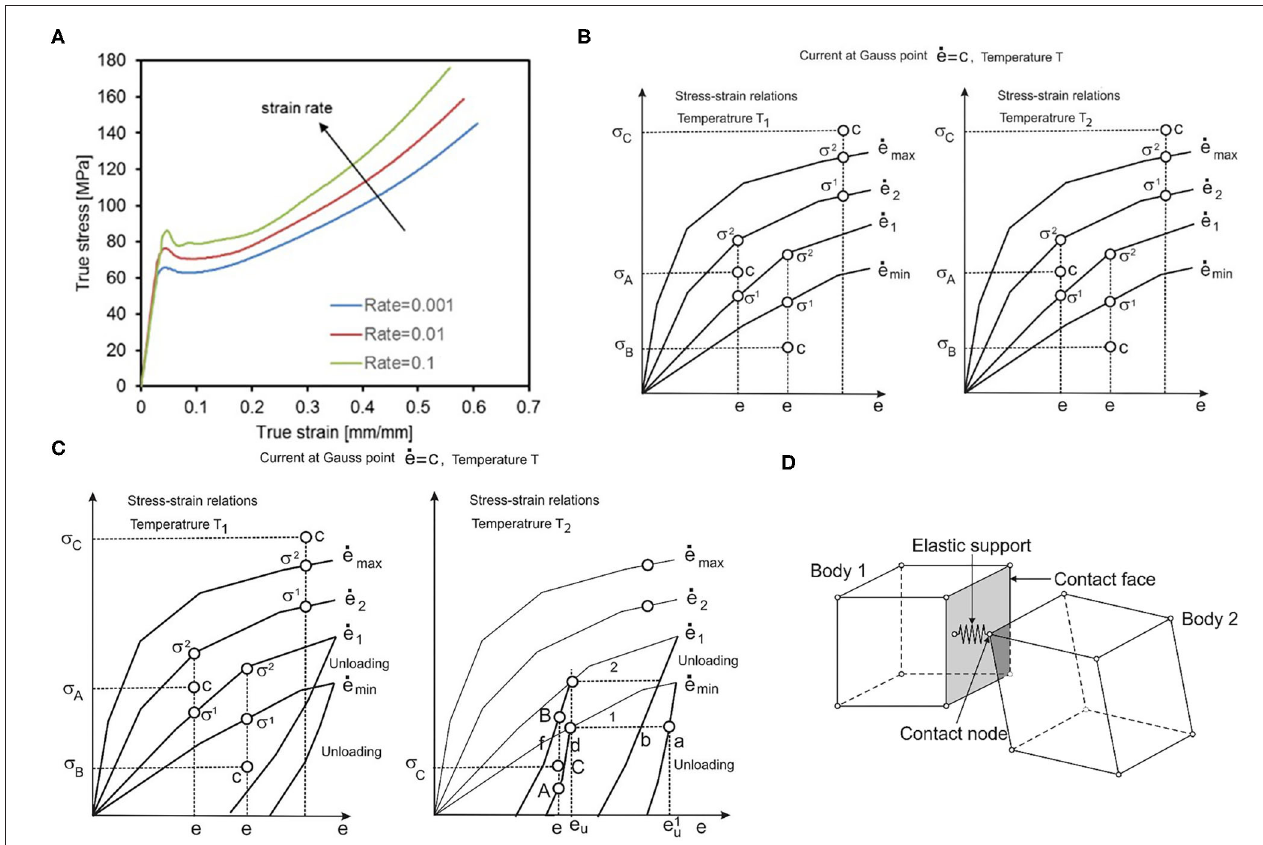
FIGURE 2 | (A) Average tensile test results provided by BSL and strain rates, (B) Uniaxial stress-strain curves for different strain rates and one temperature, (C) with unloading curves, one unloading curve corresponds to each loading curve. (D) Interaction between solid bodies, two bodies in contact, and elastic support placed in contact